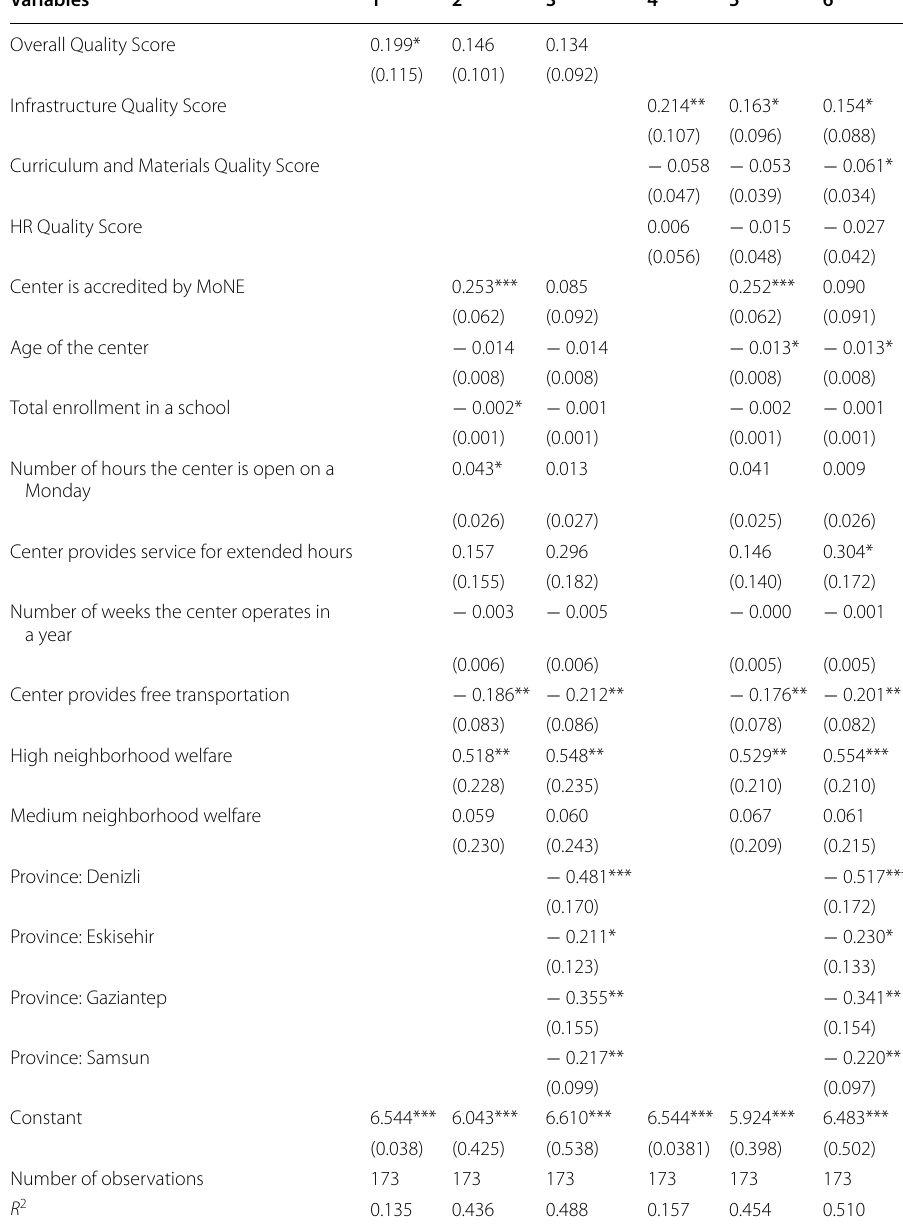
Table 2 OLS results for the price